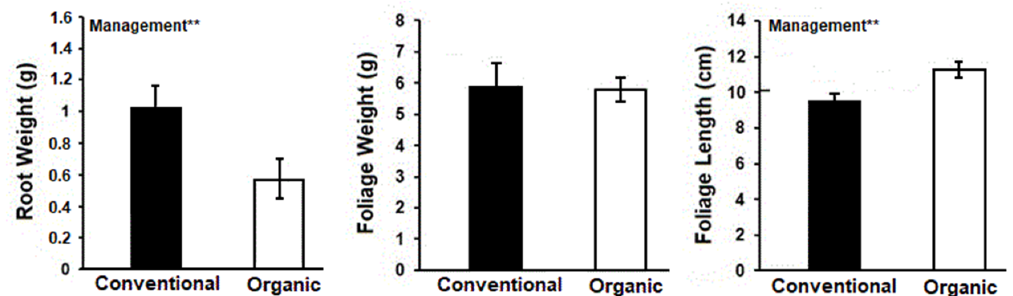
Figure 1. Mean values ( ± SE) of root weight, shoot weight, and shoot length in conventionally and organically managed systems. “Management” on the top of the graphs, indicates a significant effect of the management type, as revealed by two-way analysis of variance (ANOVA). (**: p < 0.01)